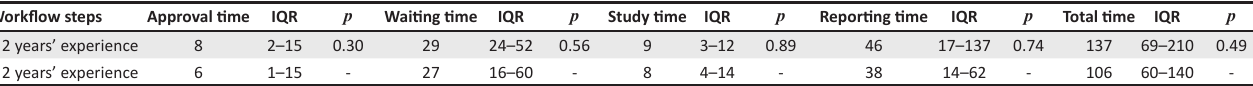
TABLE 4: Radiologist parameters. Workflow